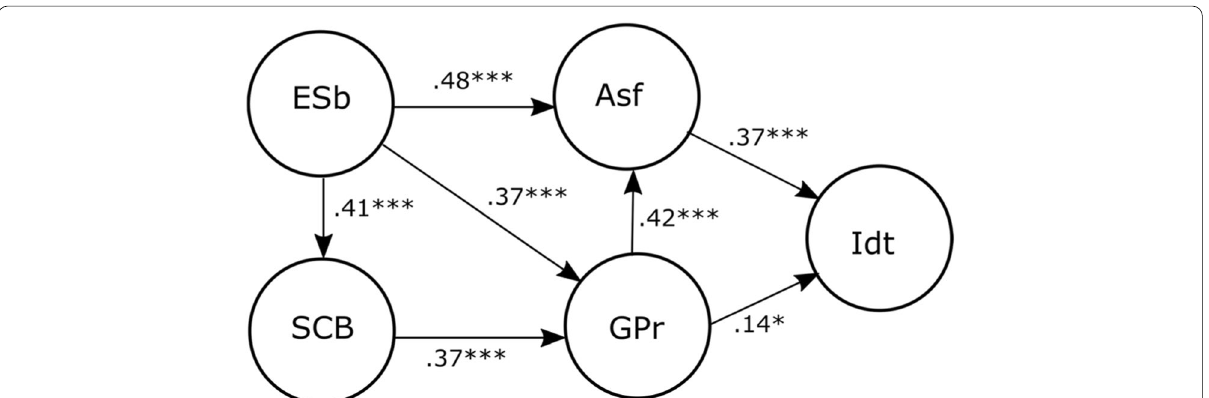
Fig. 2 Factorial weights of model variables. Note. ESb, environmental support and barriers; SCB, self-efficacy to copy with barriers; ASf, academic satisfaction; GPr, goal progress; Idt, occupational identity. * p < .05, *** p <